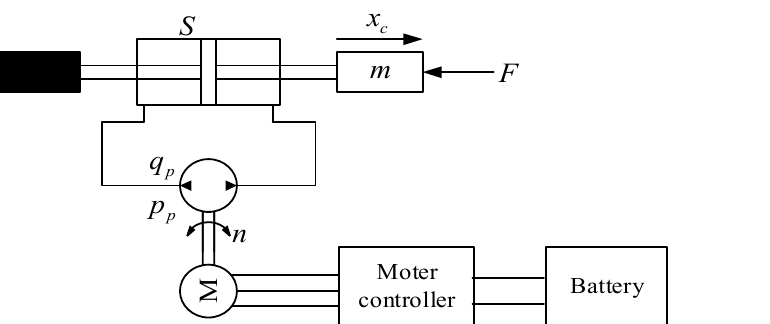
Figure 3. Simplified schematic diagram of closed pump-controlled electro-hydraulic flow matching steering system.